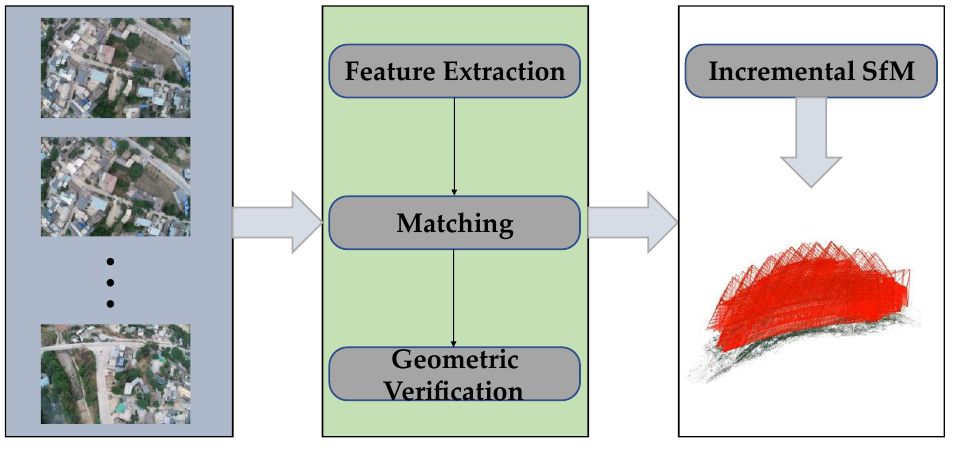
Figure 3. Principle of COLMAP [31] .